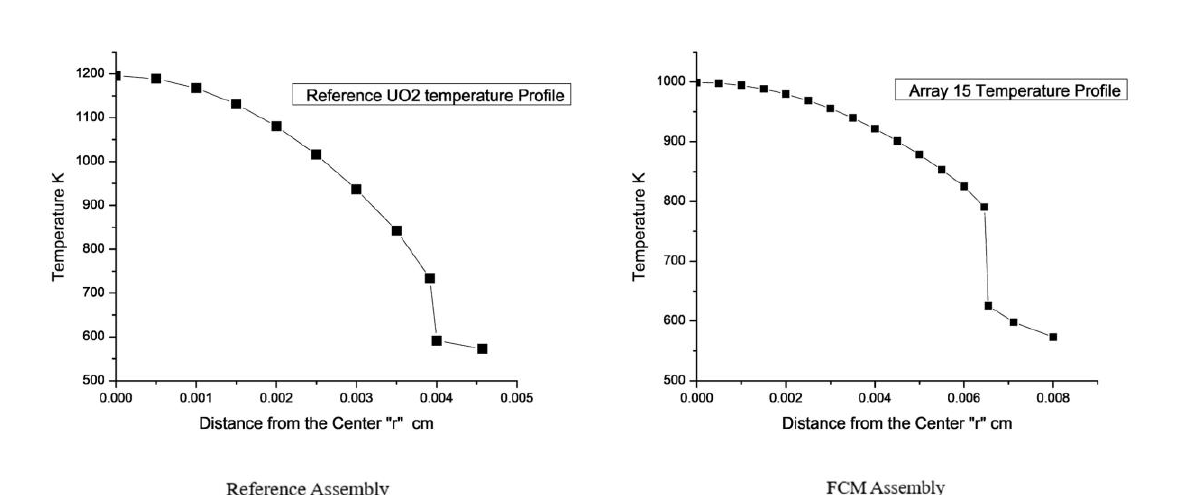
Figure 2. Fuel pin Temperature distribution of Reference and FCM